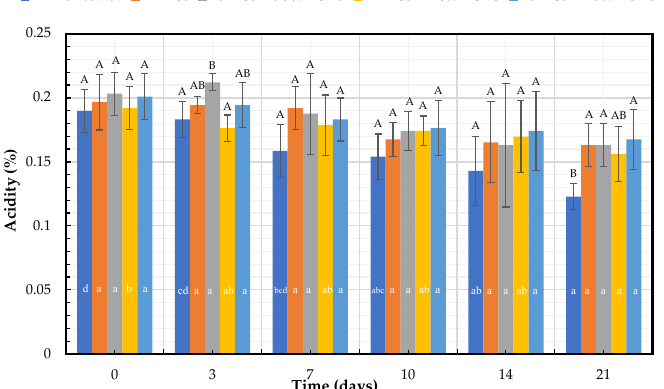
Figure 2. Evolution of the percentage of titratable acidity expressed as citric acid in pears with CS + RGEO treatments: F1= uncoated, F2 = CS, F3 = CS + RGEO 0.5%, F4 = CS + RGEO 1.0%, and F5 = CS + RGEO 1.5%. According to the ANOVA test, mean values and intervals of Duncan test for treatments and Fisher for days with 95%. Different lowercase letters (a, b, c) indicate significant differences between days according to the LSD Fisher test for each treatment in a confidence interval of 95%. In contrast, different uppercase letters (A, B, C) indicate significant differences between treatments for each day according to the Duncan test in a confidence interval of 95%.